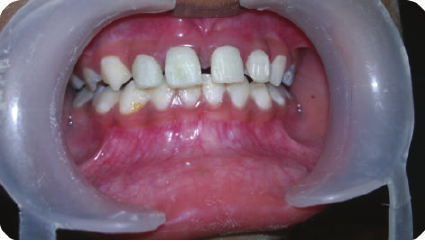
Figure 10: Postoperative clinical photograph.